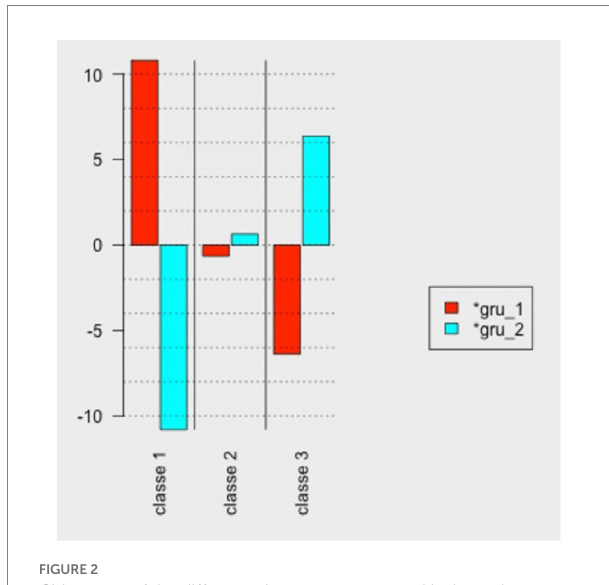
FIGURE 2 Chi-square of the difference between groups and lexicon